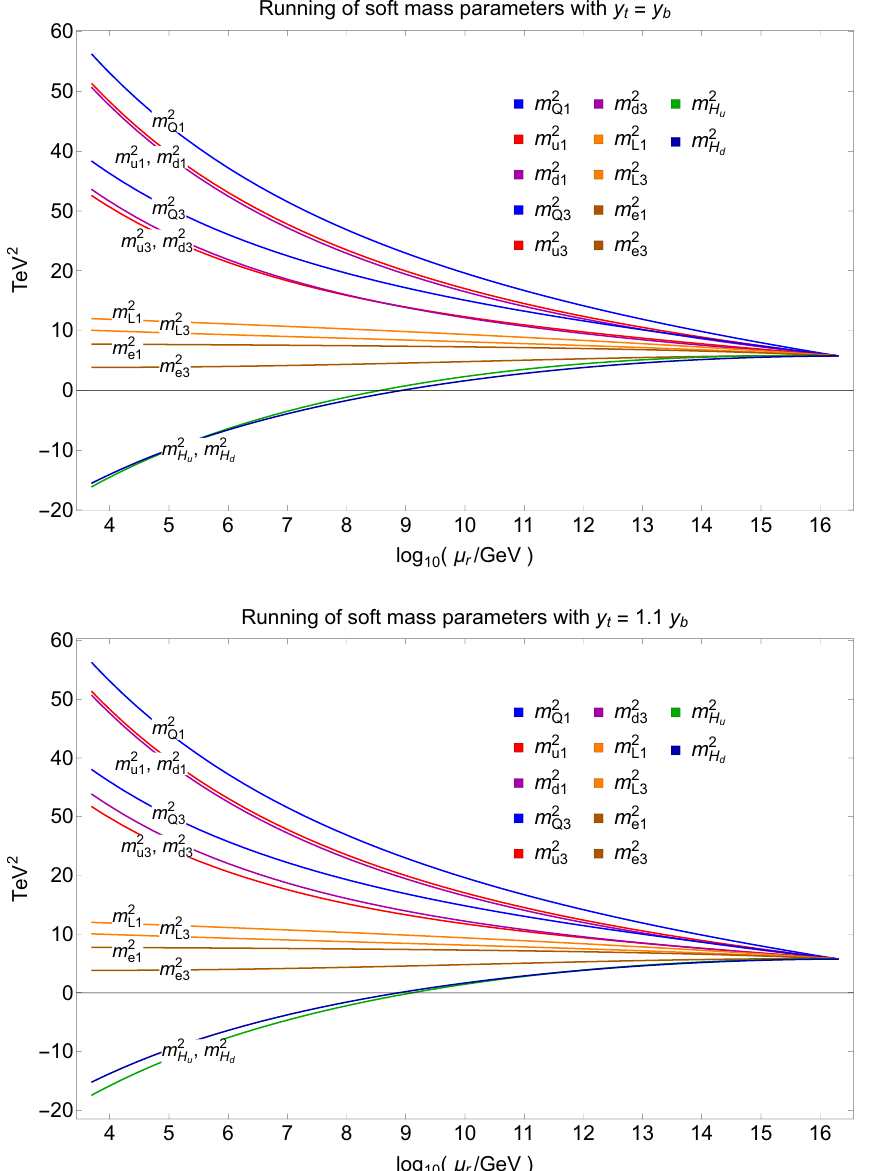
Figure 2 . The RGE running of all soft mass parameters. The two cases are for t - b uni(cid:12)cation y t = y b of the example point (1st panel) and for the modi(cid:12)ed point y t = 1 : 1 y 0 (2nd